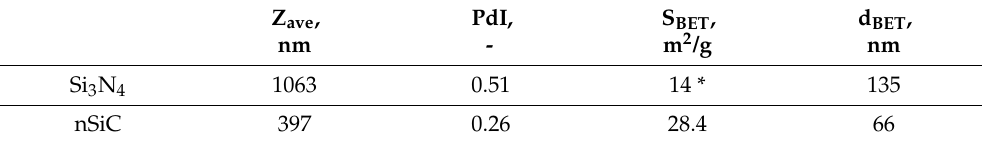
Table 1. Properties of the powders used in the research (Z ave —cumulant mean, PdI—polydispersity index, S BET —specific surface area, d BET —BET equivalent spherical particle diameter).